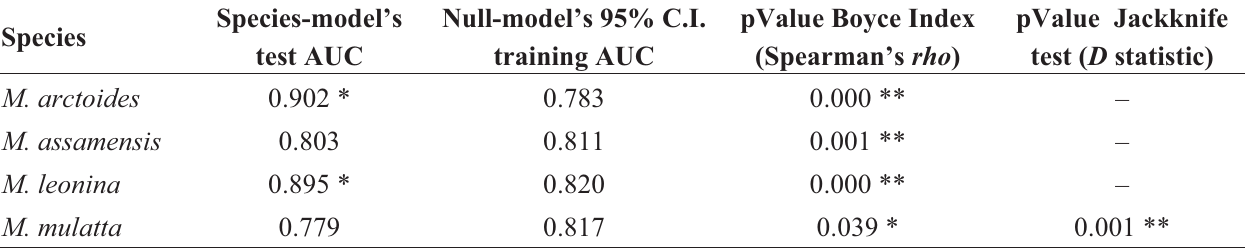
Table 3. Model validation with test area under curve (AUC) values, null-model, Boyce Index and jackknife methods.